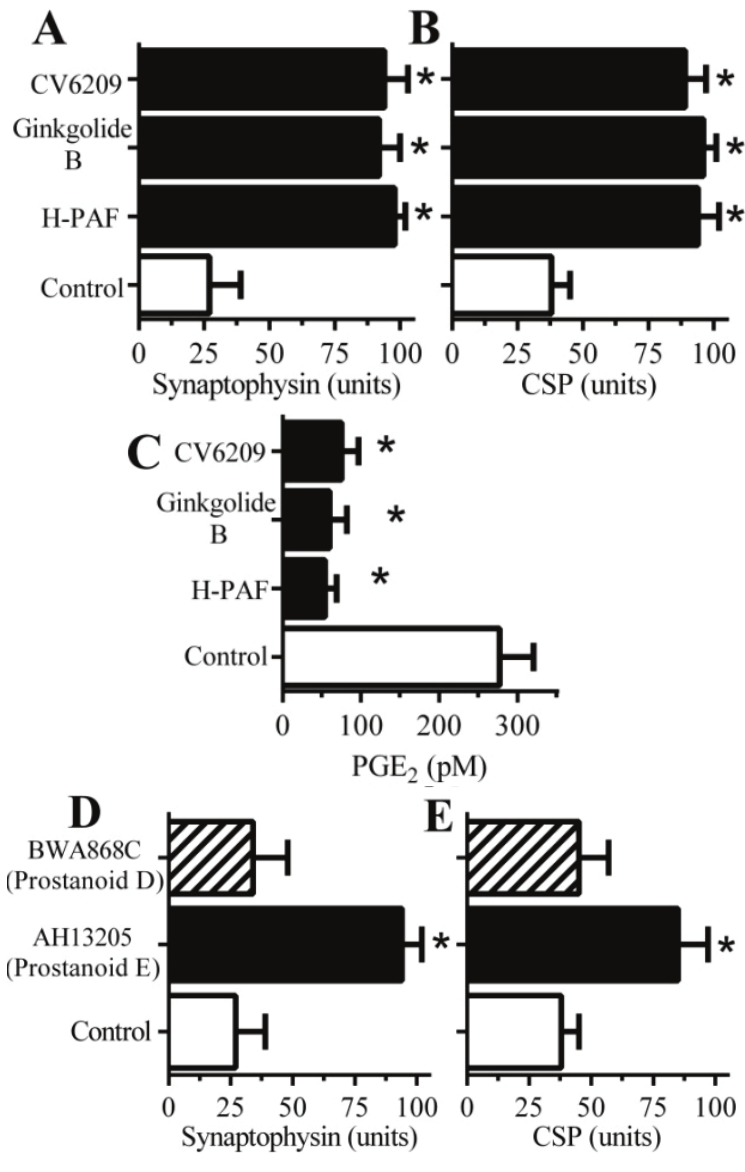
Figure 4. Platelet-activating factor (PAF) antagonists protect neurons against (cid:2)SN-induced synapse damage—The amounts of synaptophysin ( A ) and CSP ( B ) in neurons pre-treated with a vehicle control ((cid:6)) or PAF antagonists (1 μM H-PAF, ginkgolide B or CV6209 ((cid:7))) and incubated with (cid:2)SN. *= significantly higher than in control neurons incubated with (cid:2)SN. Values are means ± SD from triplicate experiments performed four times, n = 12; ( C ) The concentrations of PGE 2 produced by synaptosomes pre-treated with incubated with a vehicle control ((cid:6)) or PAF antagonists (1 μM H-PAF, ginkgolide B or CV6209 ((cid:7))) and incubated with 500 nM (cid:2)SN. Values are means ± SD from triplicate experiments performed three times, n = 9. * = significantly lower than control synaptosomes incubated with 500 nM (cid:2)SN. The amounts of synaptophysin ( D ) and CSP ( E ) in neurons pre-treated with a vehicle control ((cid:6)), the prostanoid EP receptor antagonist AH13205 ((cid:7)) or the prostanoid DP receptor antagonist BWA868C (striped bars) and incubated with 1 (cid:8)M (cid:2)SN. Values are means ± SD from triplicate experiments performed four times, n = 12. * = significantly higher than in control neurons incubated with